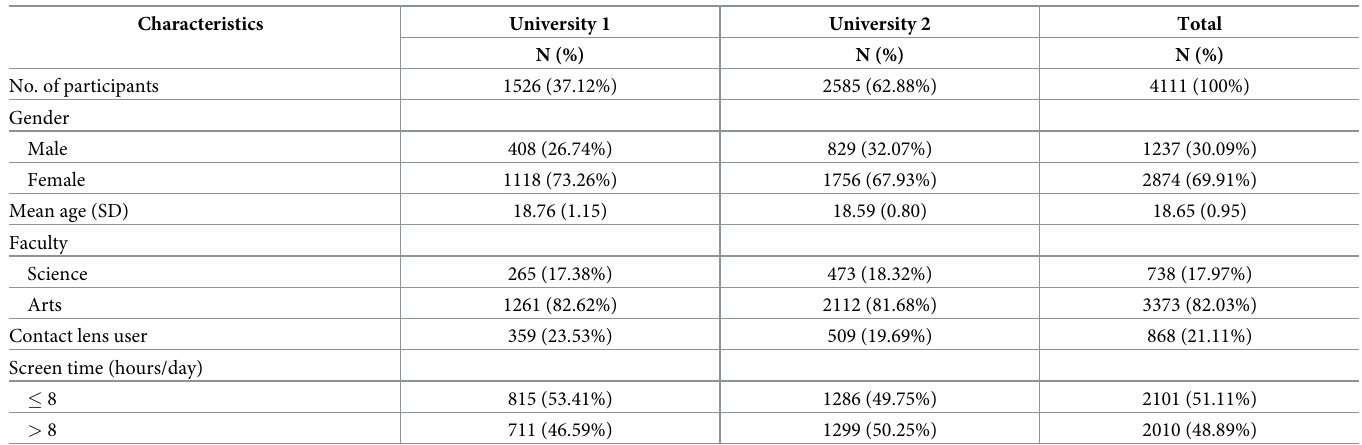
Table 1. Participant characteristics between 2 universities.